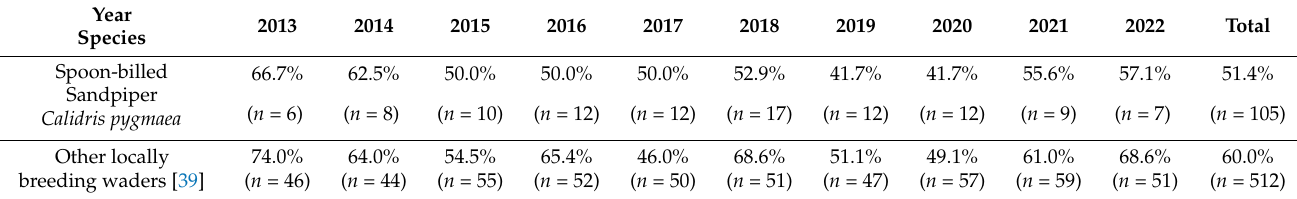
Table 1. Percentage of monitored wader nests that survived to hatching in the vicinity of Meinypil’gyno in